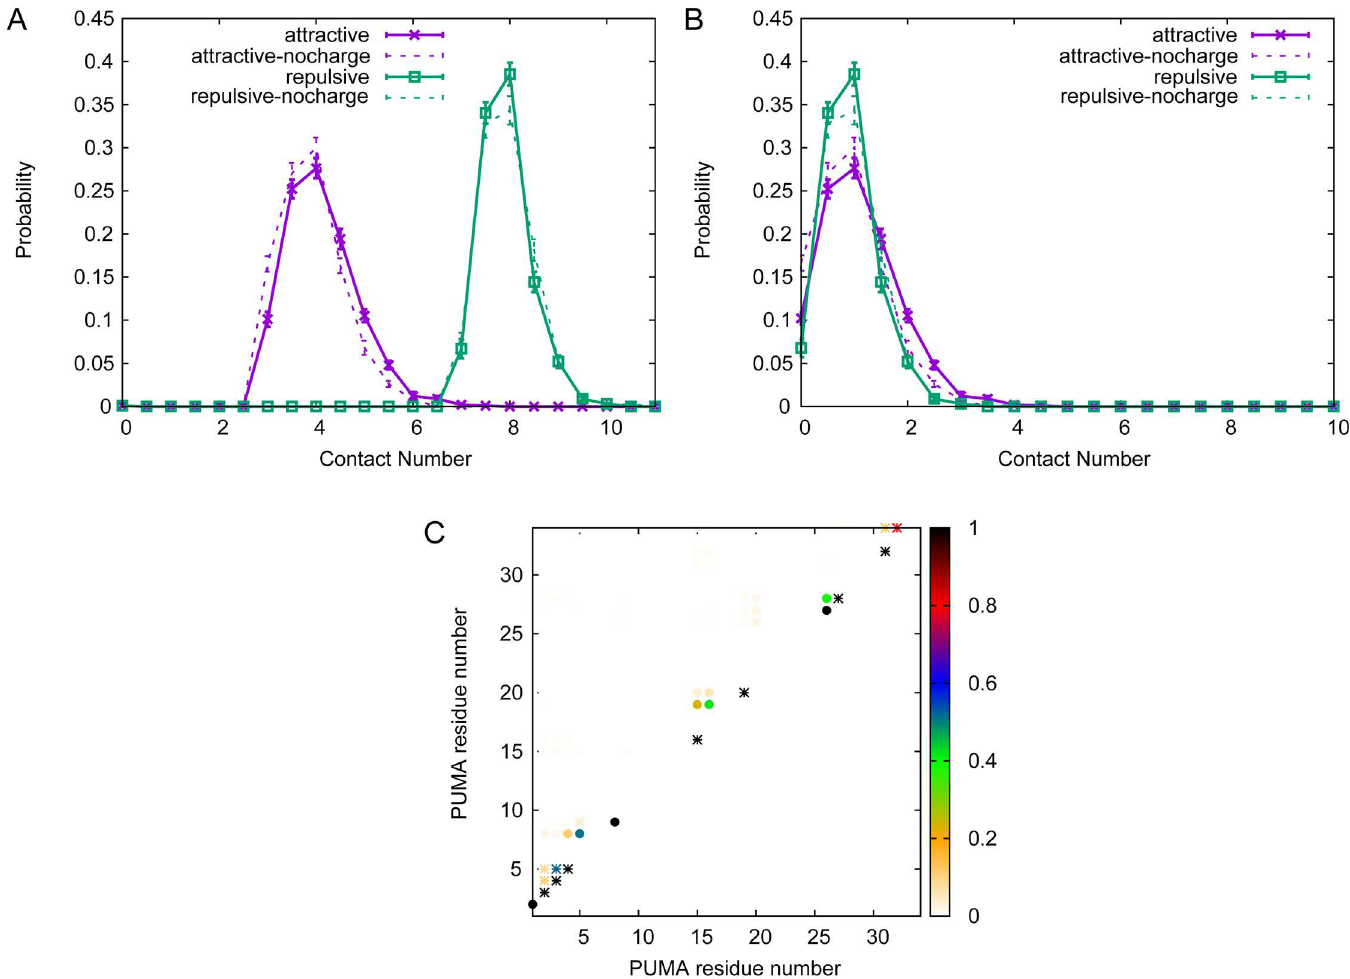
Fig 3. Contact information within PUMA. Repulsivechargecontacts betweendirectly connectedresidues dominatecharge interactions within PUMA peptide. (A) the contact number distribution with standarddeviationbetweenall chargedresidues of PUMA i.e. between i and j atoms with j i − j j(cid:21) 1. (B) the contact number distribution with standarddeviationbetweennon-connected residues of PUMA i.e. between i and j atoms with j i − j j > 1. Data of PUMA system in 10 mM ionic strength are shown with solid lines; data of PUMA system without charge interactions are shown with dashedlines. (C) the probabilityof each charge-charge interaction within PUMA in 10 mM ionic strength. Attractive and repulsivecontacts are depictedby dots and asterisks, respectively.